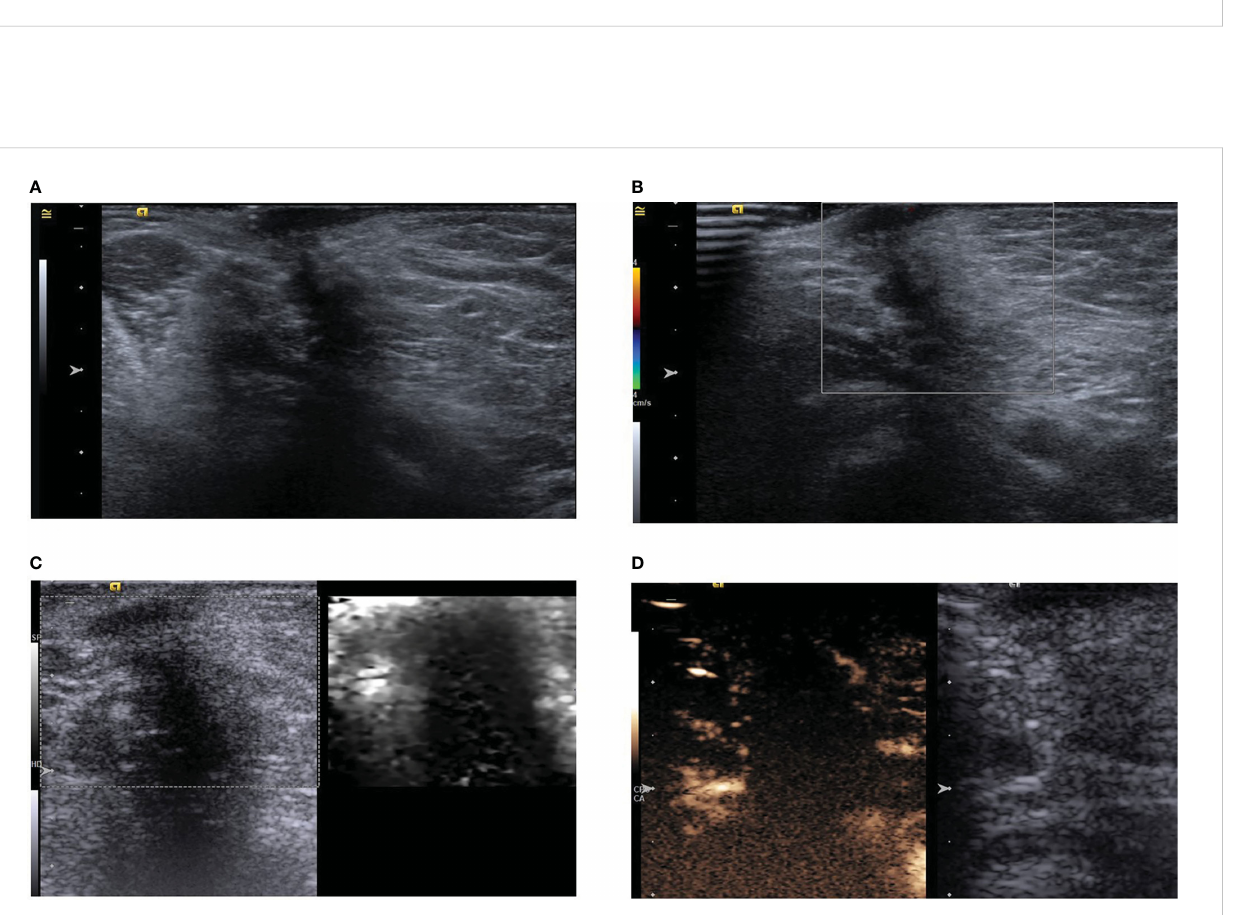
FIGURE 3 (A) Ultrasound showing a hypoechoic subcutaneous mass in the left axilla with an aspect ratio greater than one and acoustic shadowing. (B) Color Doppler shows no obvious blood supply in the mass. (C) Acoustic radiation force impulse model. (D) In the arterial phase, the tumor is slightly enhanced in the periphery, but not in the